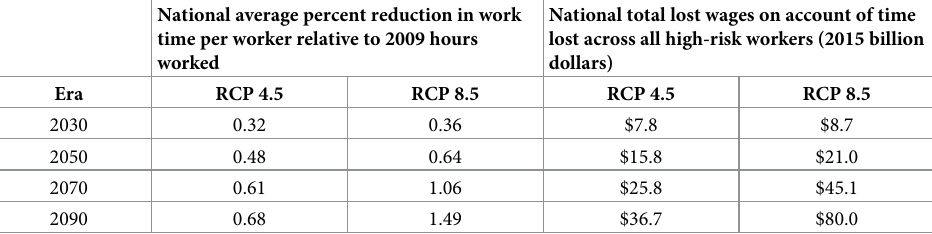
Table 4. National-level projections of lost labor time and lost wages due to climate